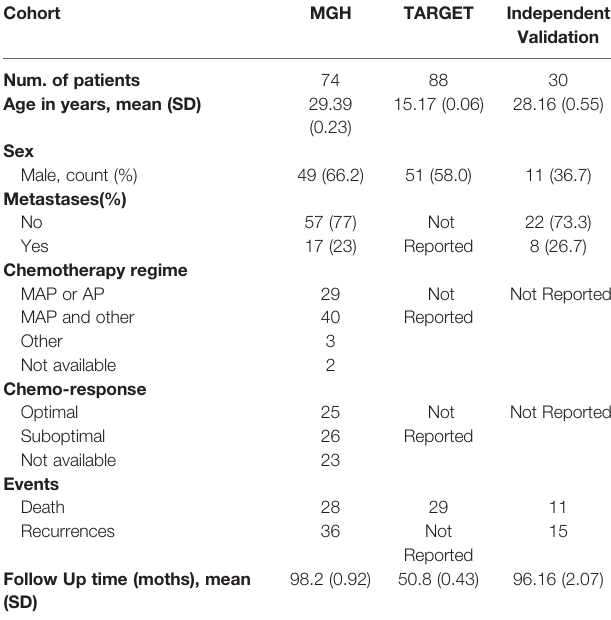
TABLE 1 | Clinical characteristics of